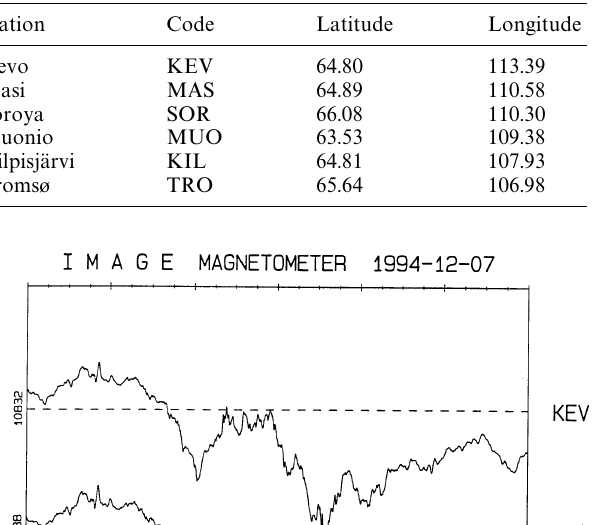
Table 1. Geomagnetic location of IMAGE magnetometer chain stations